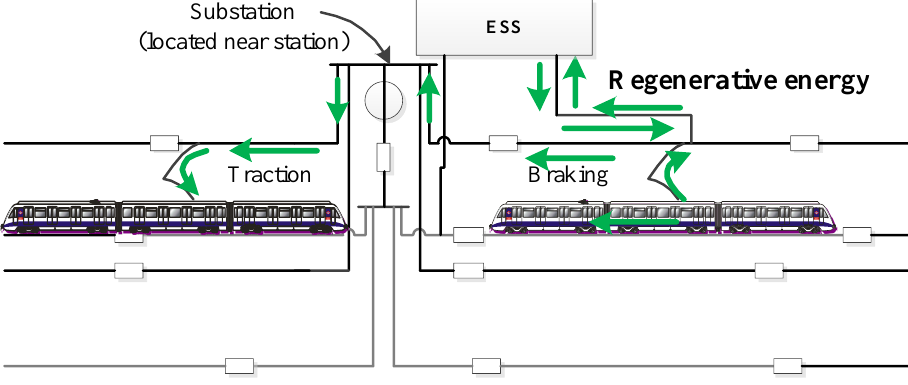
Figure 9. Energy exchange between trains through energy storage systems